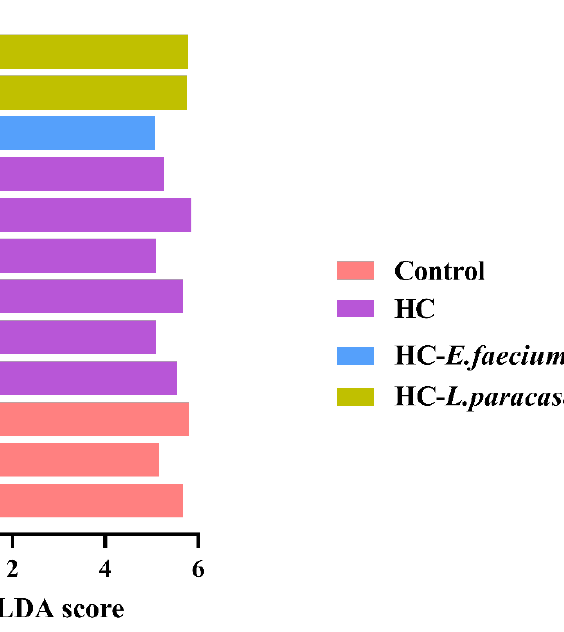
Figure 7. Linear discriminant analysis (LDA) and effect quantity (LEfSe) were used to compare the microflora distribution among groups. LDA score > 4, FDR value < 0.1. The pink bar represents the control group, the purple bar represents the HC group, the blue bar represents the HC- E. faecium strain 132 group and the yellowish-brown bar represents the HC- L. paracasei strain 201group.